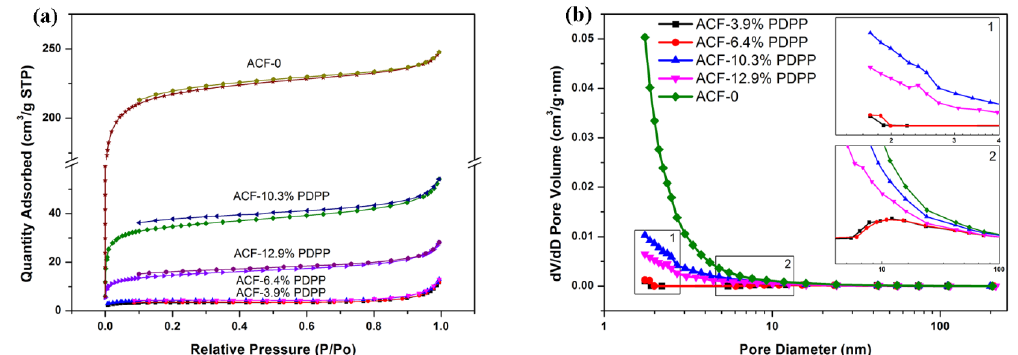
Figure 5. ( a ) Nitrogen adsorption and desorption isotherms, and ( b ) pore size distribution of ACF-0, ACF-3.9% PDPP, ACF-6.4% PDPP, ACF-10.3% PDPP, and ACF-12.9% PDPP samples.